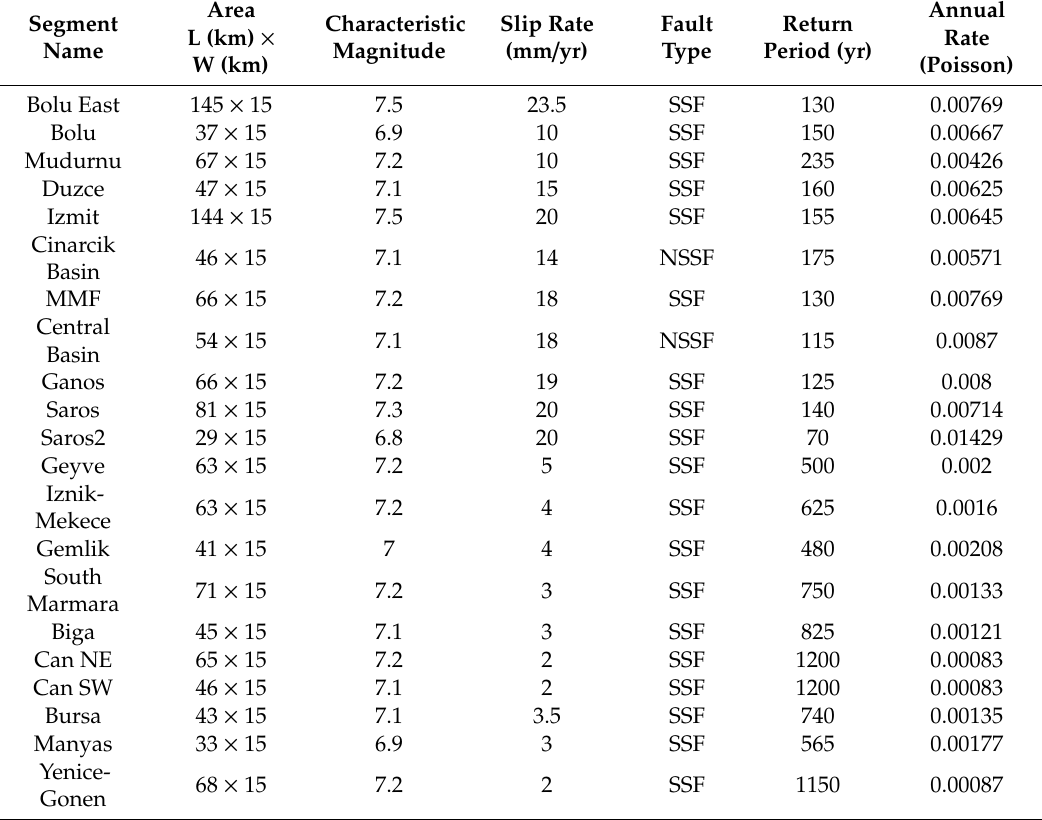
Table 3. Mean return periods and annual rates of occurrence of characteristic